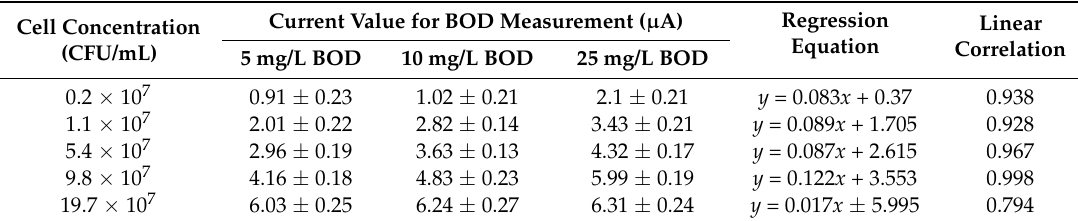
Table 2. Comparison of the relationship between cell concentration for microbial biofilm preparation and BOD measurement in low